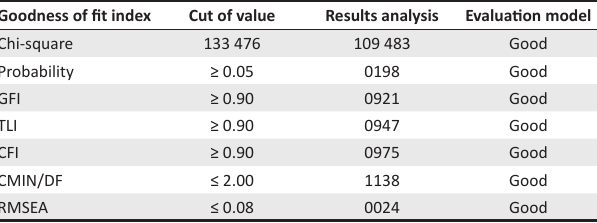
TABLE 2: Results of feasibility model.